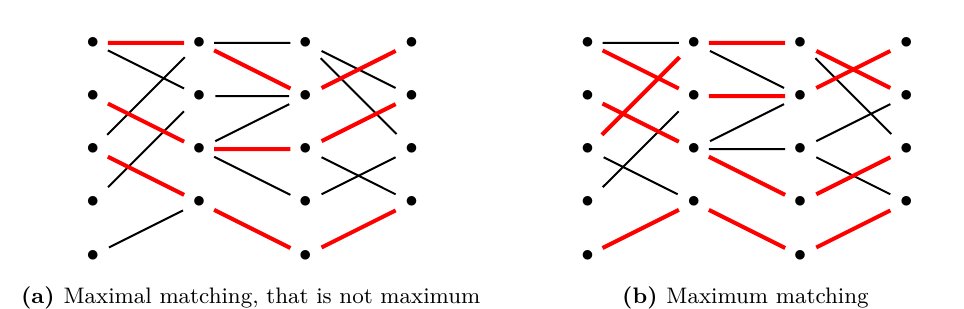
Figure 1: A maximal matching is shown in sub-figure 1a. This matching is not